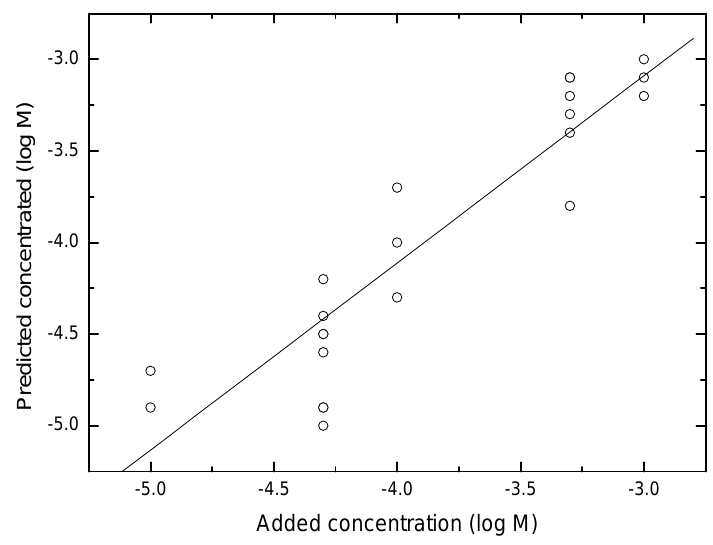
Figure 8. Calibration curve (27 samples) of n-butyrate in test mixtures of key odorants containing p- cresolate at pH 6. BPNN used 5, 2, 1